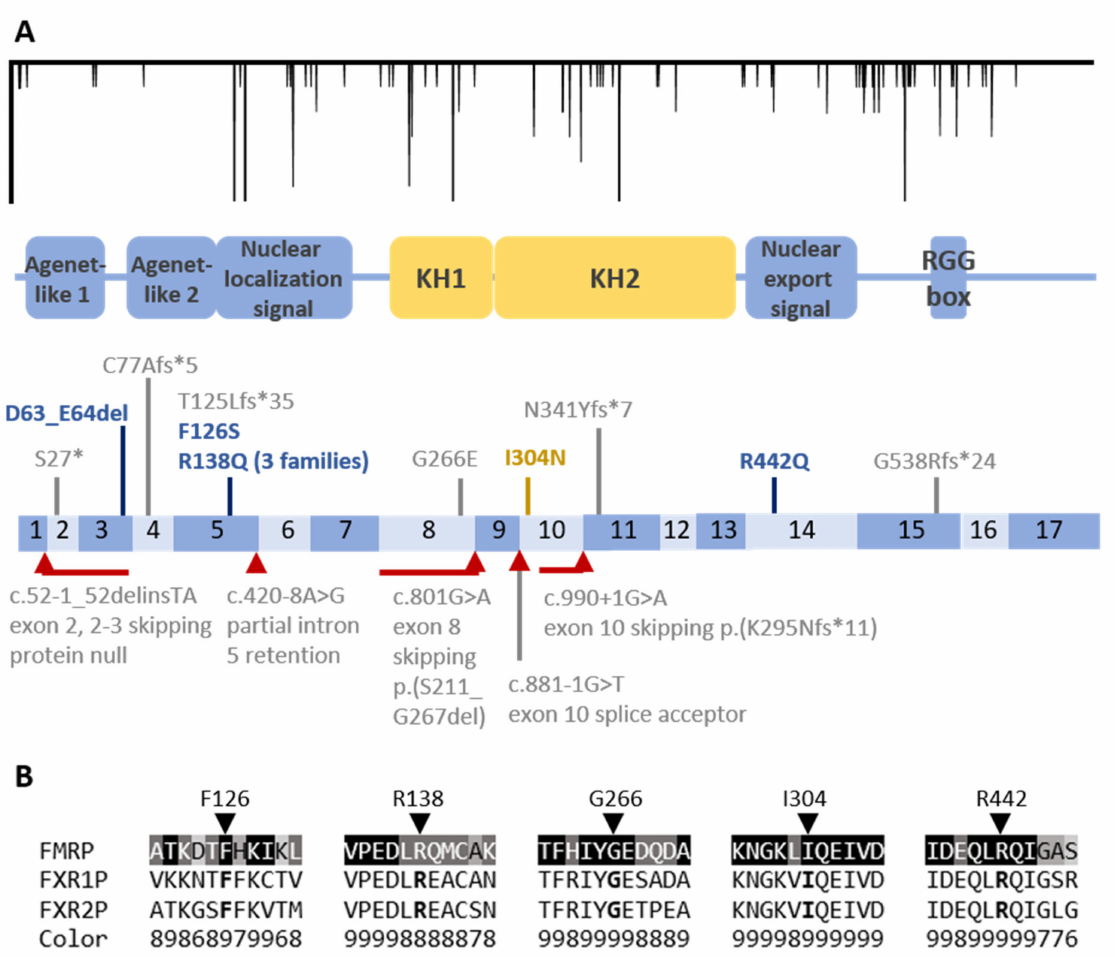
Figure 1. ( A ) Pathogenic and likely pathogenic small variants in FMR1 in relation to exons and protein functional domains. The FMR1 coding sequence (c.1-1899) is shown to scale with functional domain locations from the work of [95]. At the top, genetic variation in the general population is graphed with the x-axis showing c. locations and the y-axis showing the total minor allele frequency of missense and canonical splice variants in gnomAD (with higher frequencies extending farther downward, with several common variants clipped to a maximum frequency of 5 × 10 − 5 .) Below, protein domains and exons 1–17 (dark and light boxes) are shown with the 11 coding variants above and 5 splice variants below the exon schematic. ( B ) Protein sequence conservation of the 5 residues involved in pathogenic missense variation. For each location, 11 aa of FMRP sequence around the residue is shown aligned to the paralogous FXR1P and FXR2P sequences. The FMRP sequence is color-colored based on evolutionary conservation from 1 (variable) to 9 using